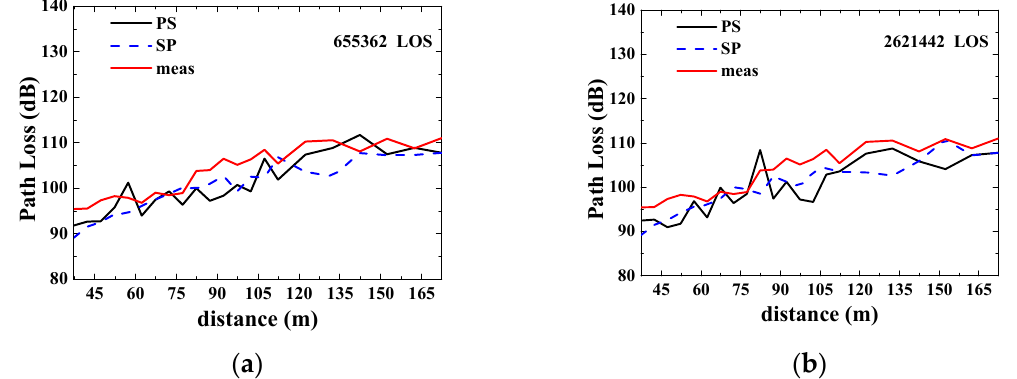
Figure 13. Path loss comparison of theoretical calculation with measured data for 655,362 and 2,621,442 rays in the LOS. ( a ) The number of rays is 655,362 ( b ) The number of rays is 2,621,442. Table 3. The RMSE in the LOS.